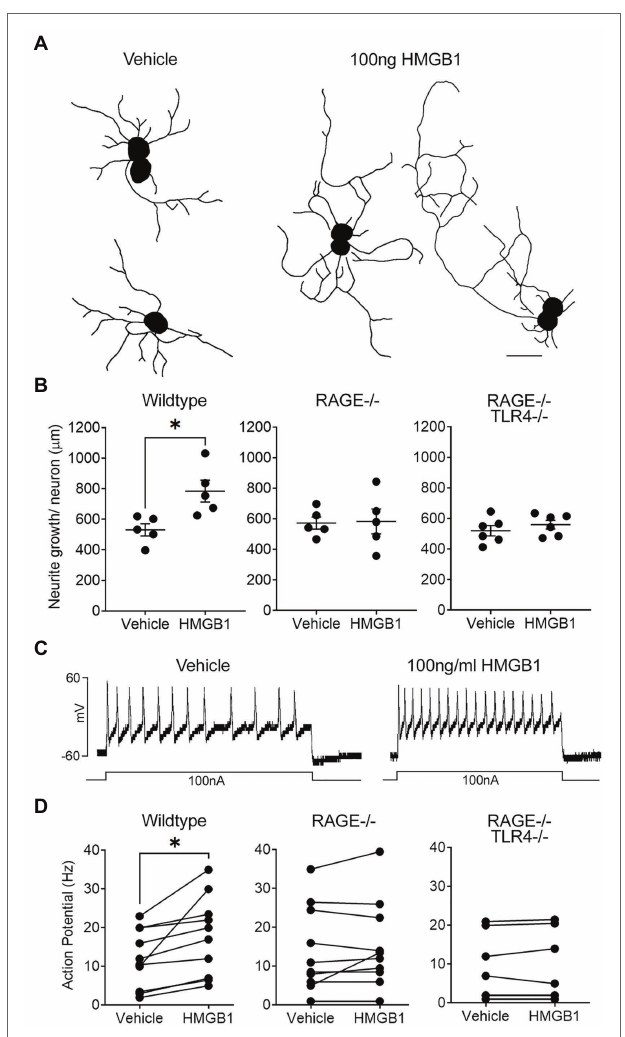
FIGURE 2 | High mobility group box-1 (HMGB1) evokes Receptor for Advanced Glycation End products (RAGE)-dependent neurite outgrowth and alters the electrophysiological properties of vagal sensory neurons. (A) Representative individual neurite outgrowth tracings of vagal sensory neurons cultured in the presence of vehicle and HMGB1. Scale bar = 50 μm. (B) Quantitative data showing the effects of HMGB1 on neurite outgrowth in neurons from wildtype, RAGE deficient (RAGE − / − ), and RAGE/Toll-like Receptor 4 (TLR4) double deficient (RAGE − / − /TLR − / − ) mice. Each dot represents one animal with the average neurite outgrowth of a minimum of five cells manually traced and analyzed for one replicate coverslip ( n = 5 experiments) with overall group mean and SEM plotted. (C) Representative current clamp recordings from a wild-type vagal ganglia neuron showing injected current evoked action potential formation (spiking) in the presence of vehicle and HMGB1. (D) Quantitative data showing action potential firing frequency (spikes per second, Hz) for individual neurons obtained from wildtype, RAGE − / − , and RAGE − / − /TLR − / − mice in the presence of vehicle or HMBG1. * p < 0.05 significantly different to vehicle as determined by unpaired t